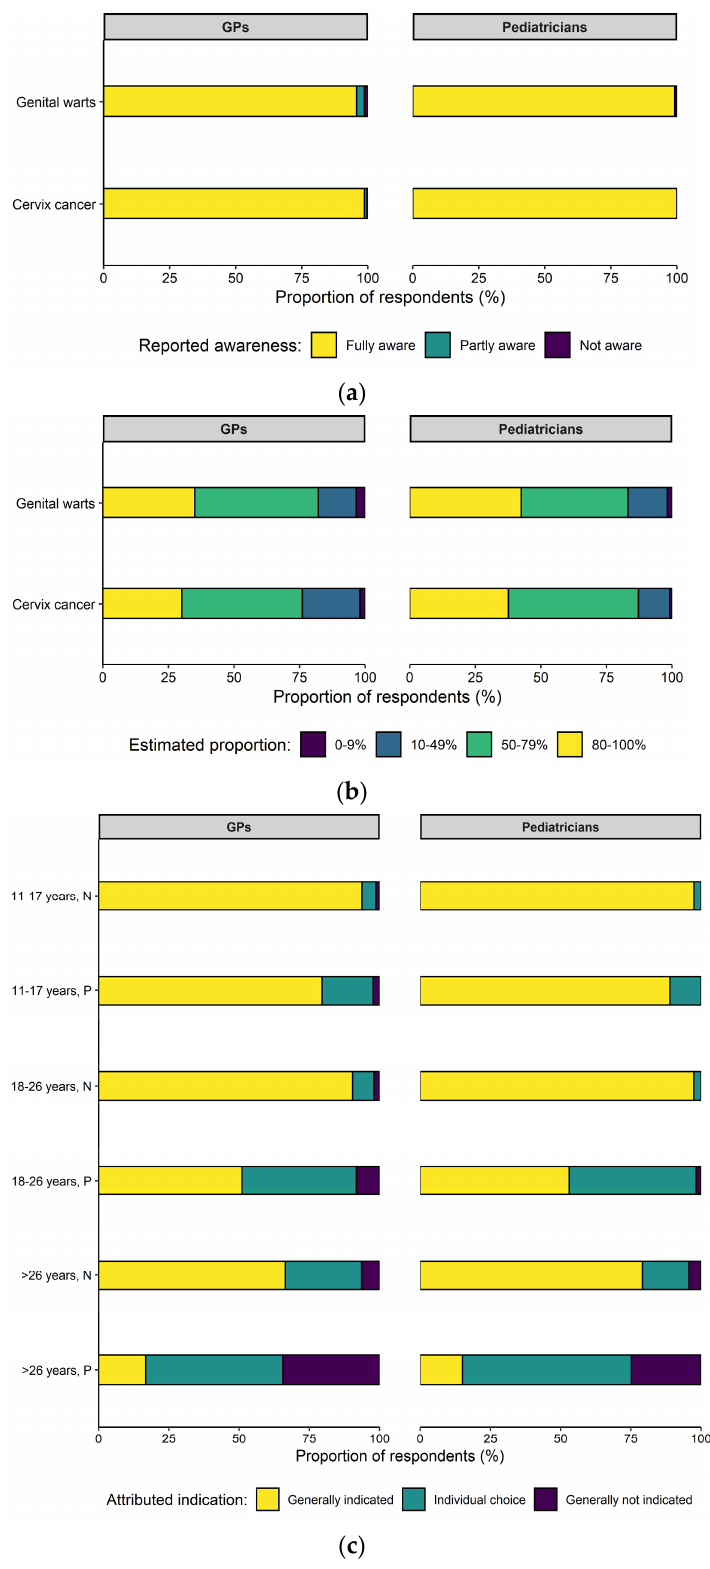
Figure 1. ( a ) The reported awareness of association of human papillomavirus (HPV) infection with cervix cancer and genital warts. ( b ) For the same diseases, the estimated fraction of cases preventable by the currently available nine-valent HPV vaccine. ( c ) The indication attributed to HPV vaccination for different population groups. Abbreviations: general practitioners (GPs); negative history of sexual intercourse (N); positive history of sexual intercourse